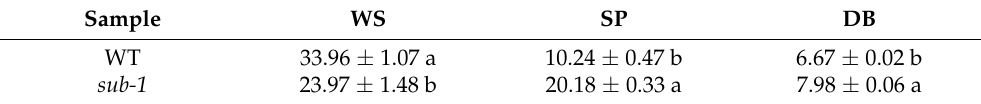
Table 3. Water solubility, swelling power and branching degree